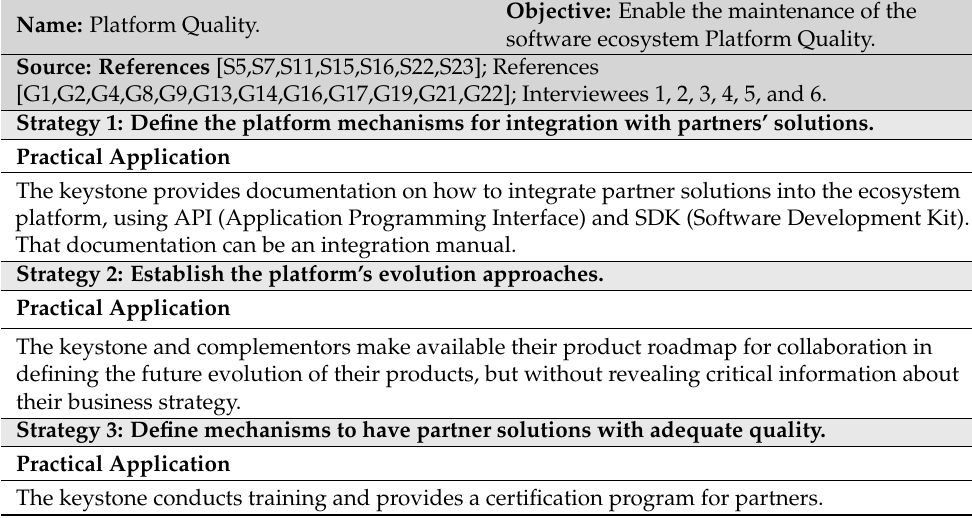
Table 8. Pattern 1—Platform